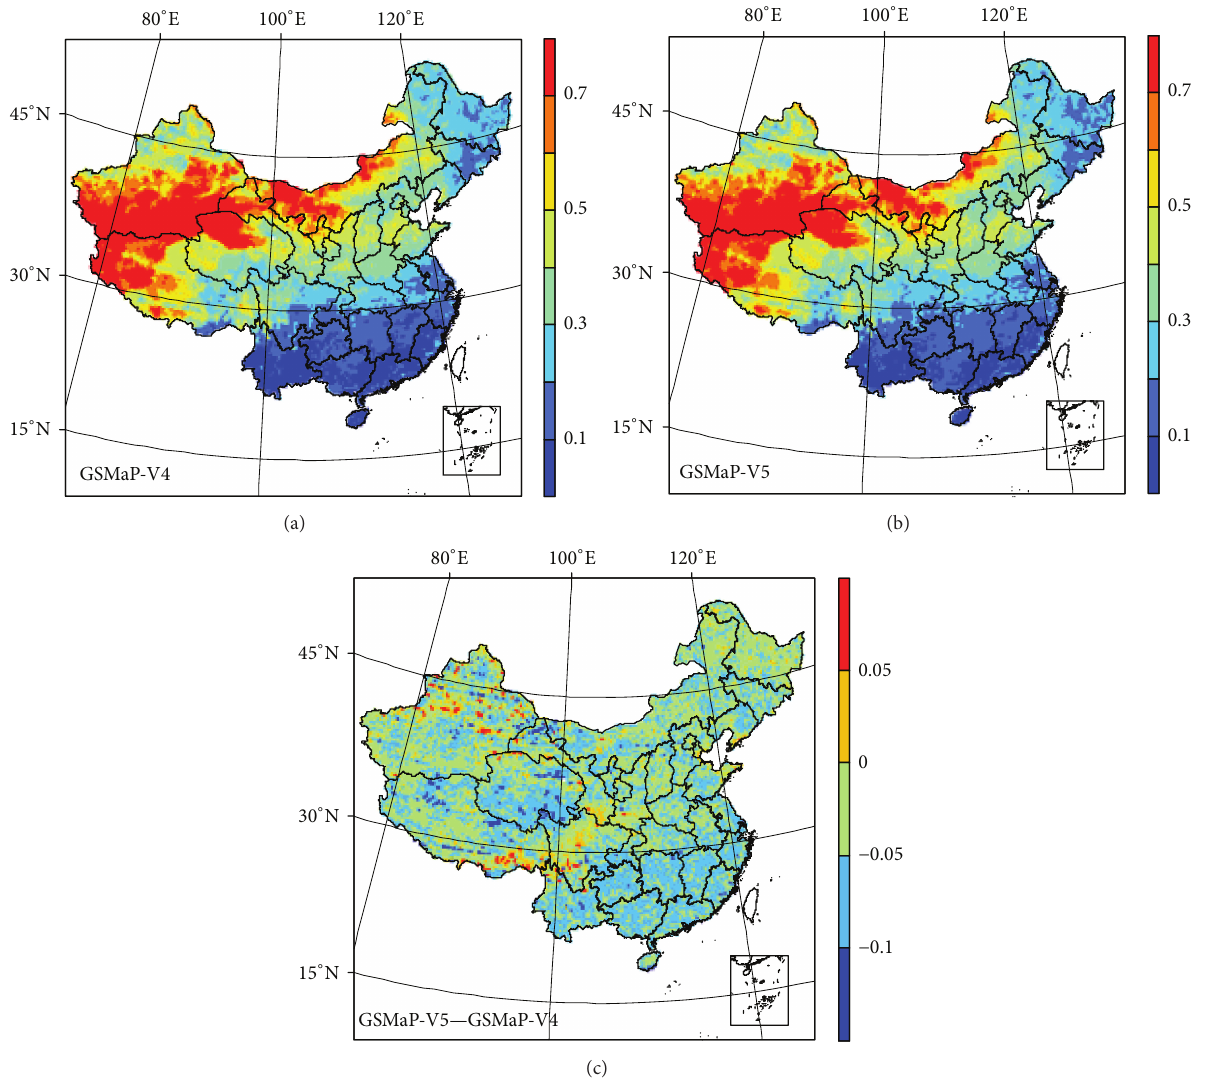
Figure8: Distributionof false-alarmratio forGSMaP productsover theChineseMainland from2003 to 2006. (a) GSMaP-V4, (b)GSMaP-V5, and (c) difference between GSMaP-V4 and